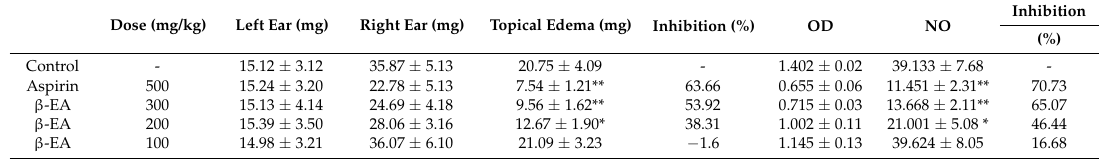
Table 3. Effect of β -EA on xylene induced ear inflammation in mice ( n =